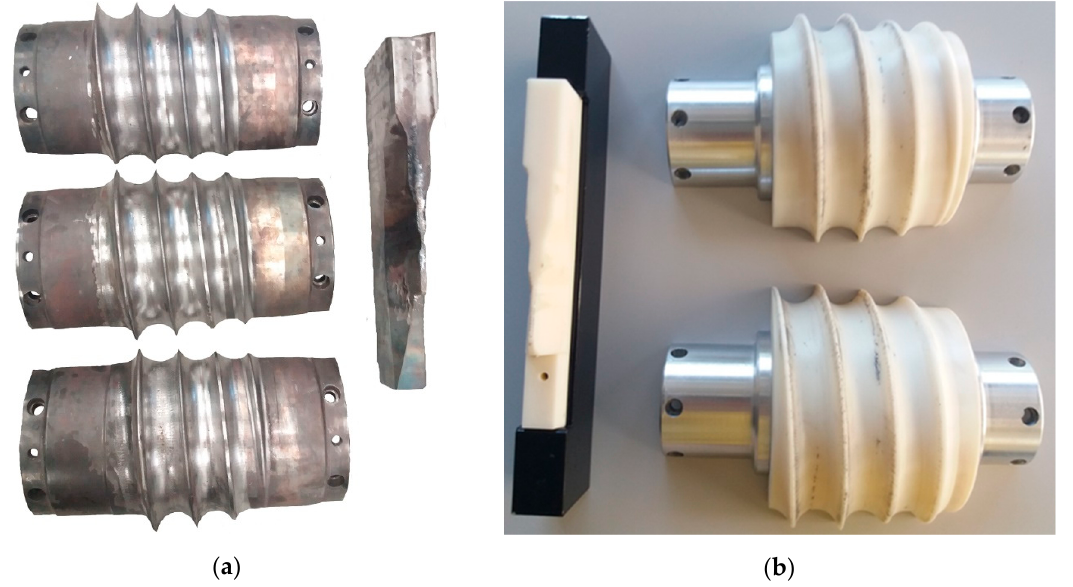
Figure 7. Tools for helical rolling of ( a ) 57 mm diameter steel balls; ( b ) 1:2 scale model tools for plasticine balls. Table 4. Technical specification of the skew rolling mill located in the Lublin University of Technology.